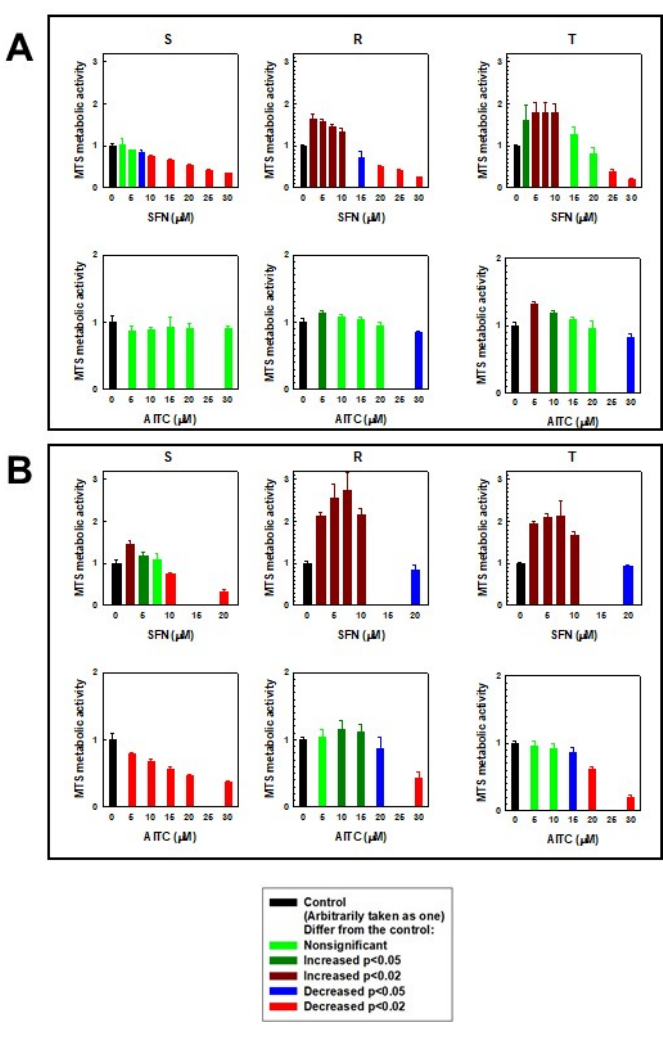
Figure 3. Effects of SFN and AITC on the metabolic activity of S, R and T cells measured by an MTS assay after 24 h (panel A ) and 48 h (panel B ). Experimental data represent the means ± S.E.M. from five independent experiments. The significance of increases or decreases is given in the legend.